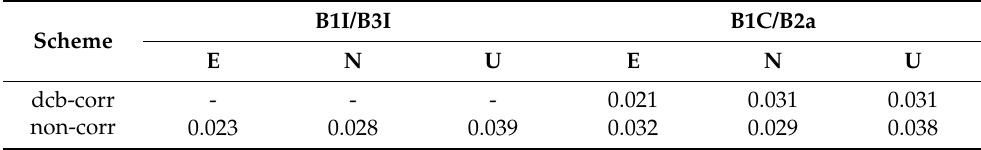
Figure 23. Average convergence time and the improvement of B1C/B2a PPP with different schemes for six stations. Although the effects of differential code biases can be mitigated as time goes by, and similar positioning accuracy can be obtained after convergence, the bias will be absorbed and affected by other parameters. Take BRCH station as an example; Figure 24 illustrates